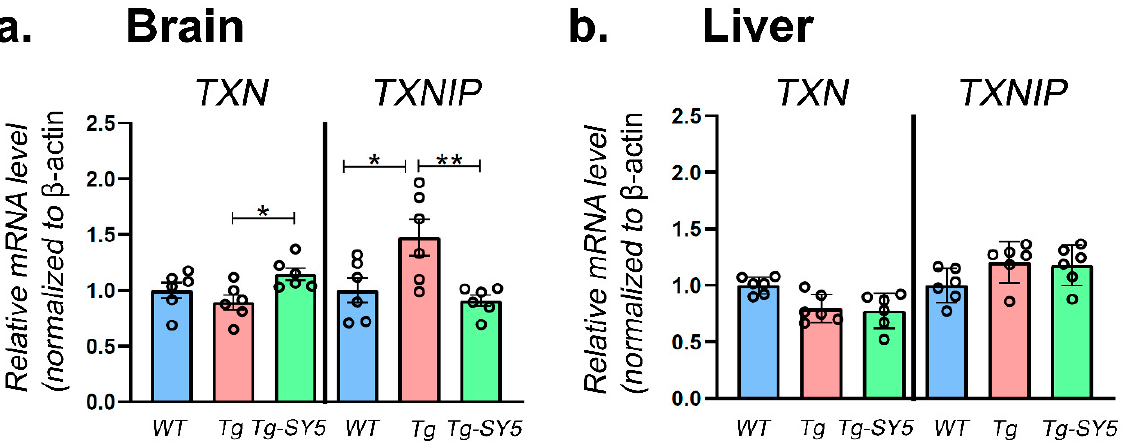
Figure 2. The TXN or TXNIP gene expression level in the amyloid precursor protein and presenilin 1 double transgenic (APP/PS1) mice in ( a ) brain and ( b ) liver. Data are presented as mean ± SEM ( n = 6). Significance: ** p < 0.01, * p < 0.05.